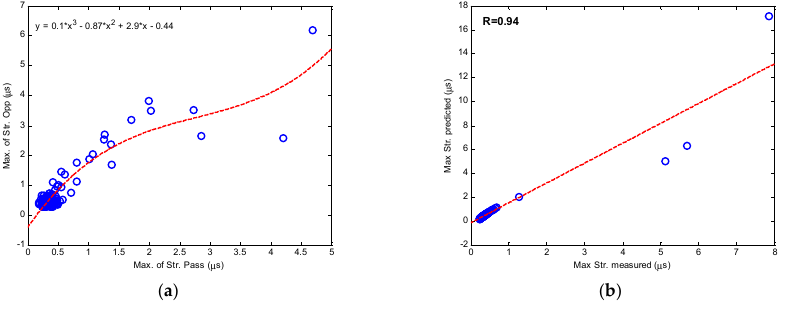
Figure 11. Cross-correlation and prediction of maximum strain dynamic. ( a ) cross-correlation maximum dynamic of strain; ( b ) predicting effect of cross-correlation.